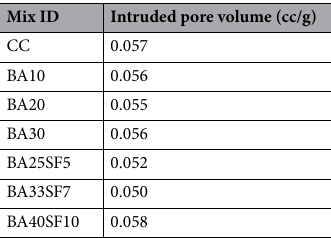
Table 8. Intruded pore volume for control and others samples having bagasse ash and bagasse ash with silica fume.